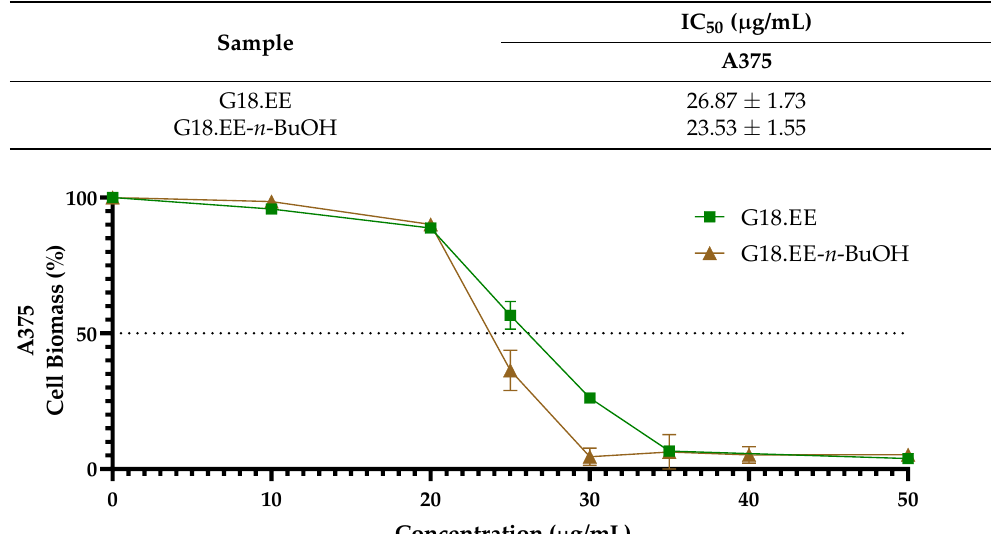
Table 1. IC 50 values of G18.EE and G18.EE- n -BuOH in A375 melanoma cell lines. A375 cells were treated for 72 h with 10 to 50 µg/mL of each sample. Results are presented as mean ± SD (n ≥ 3).